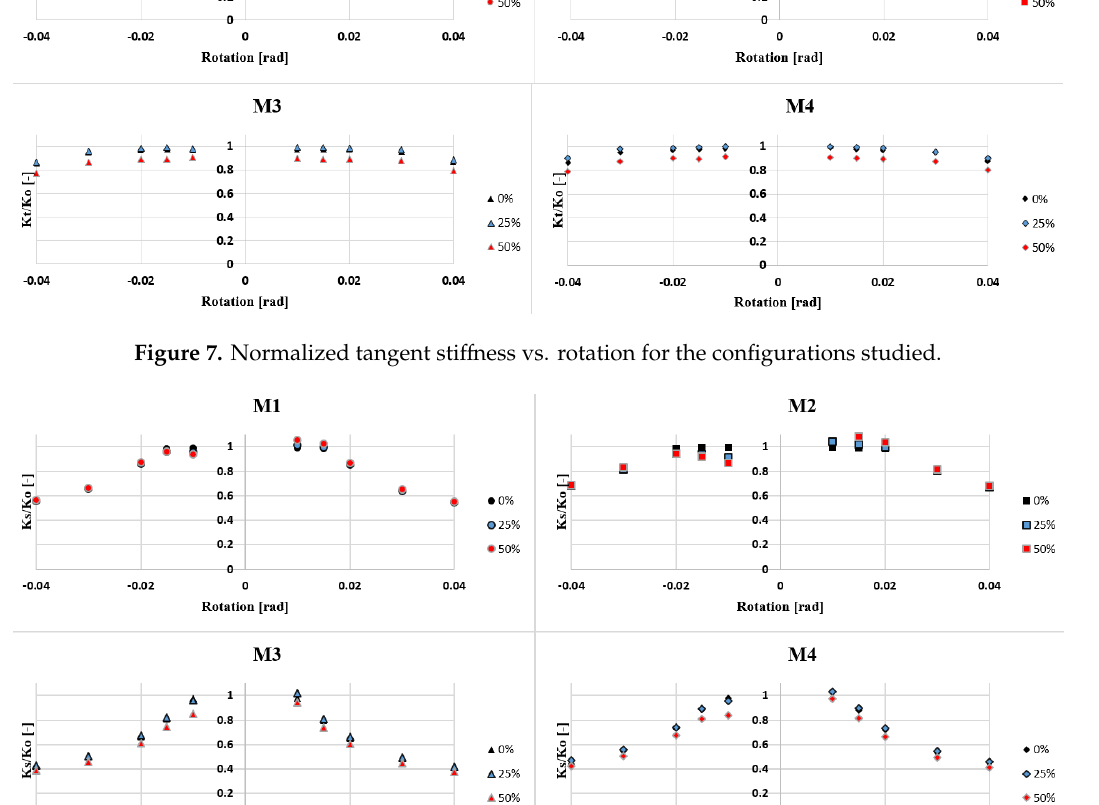
Figure 10. Equivalent damping vs. rotation for the configurations studied.